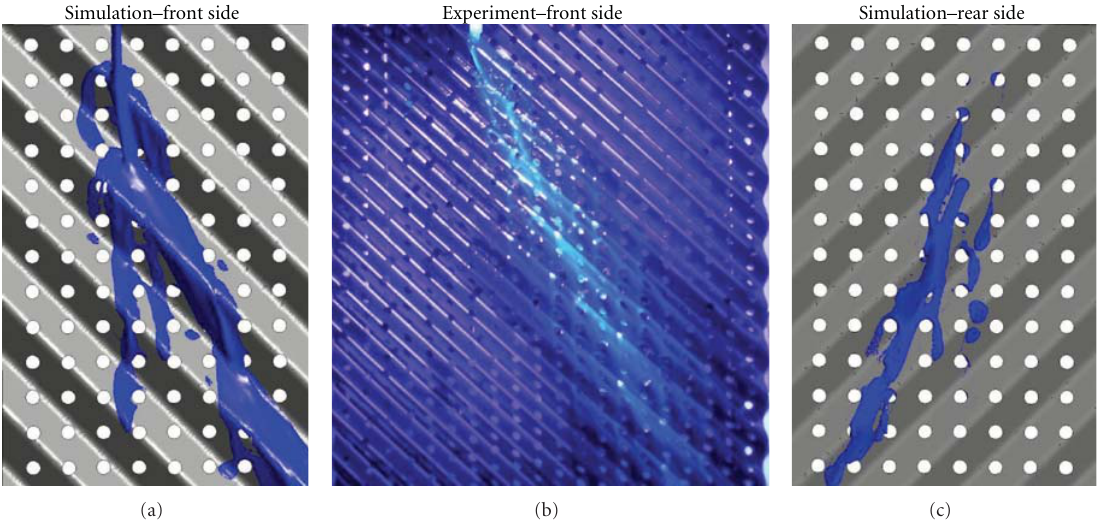
Figure 15: Comparison between simulation and experiment for flow of silicon-oil on corrugated sheet of packing with perforations. Flow rate: 508 mL/min.